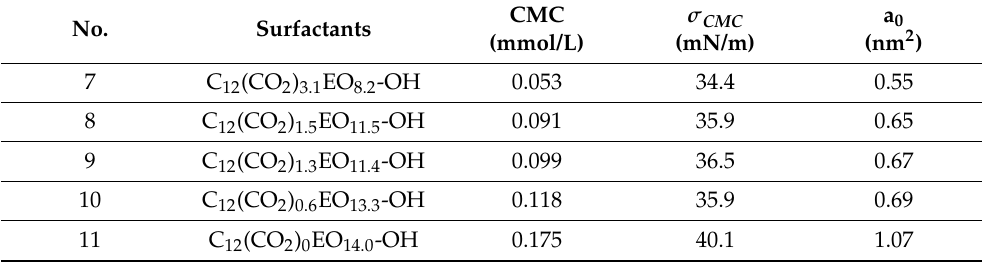
Table 3. Summarized data of the surface-tension measurements of the CO 2 -modified nonionic surfactants Adapted with permission from Ref. [23], 2023, Elsevier.